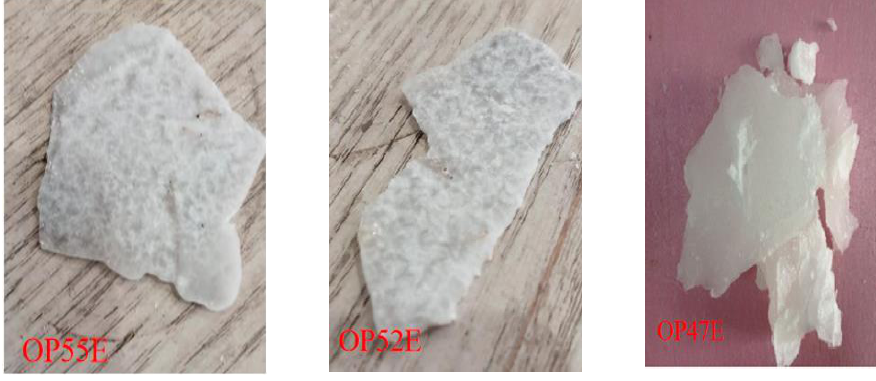
Figure 2. Pictures of different kinds of paraffin wax materials. Table 2. Thermophysical parameters for different PCM.